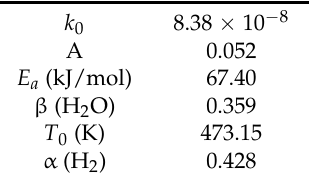
Table 2. Calculated kinetic parameters for the proposed reaction rate expression (Equation (15)) for WGS reaction on powdered PtCeAl + ZrEuMo sample.